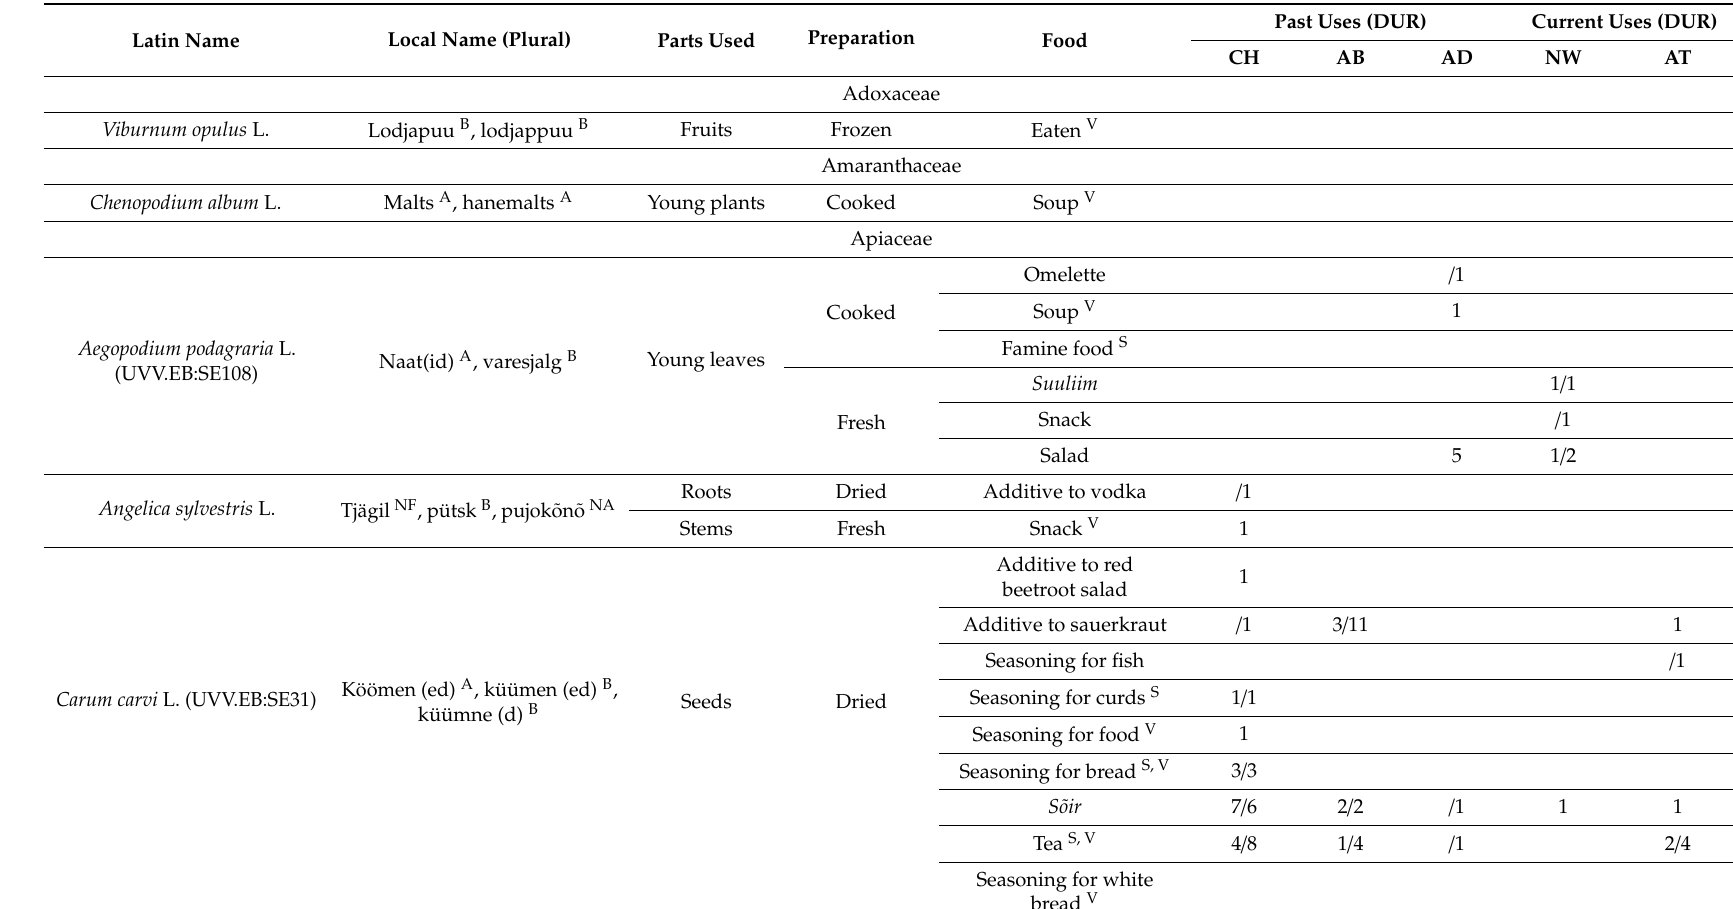
Table 2. Wild food plants use by Setos ( n = 37) / Estonians ( n =